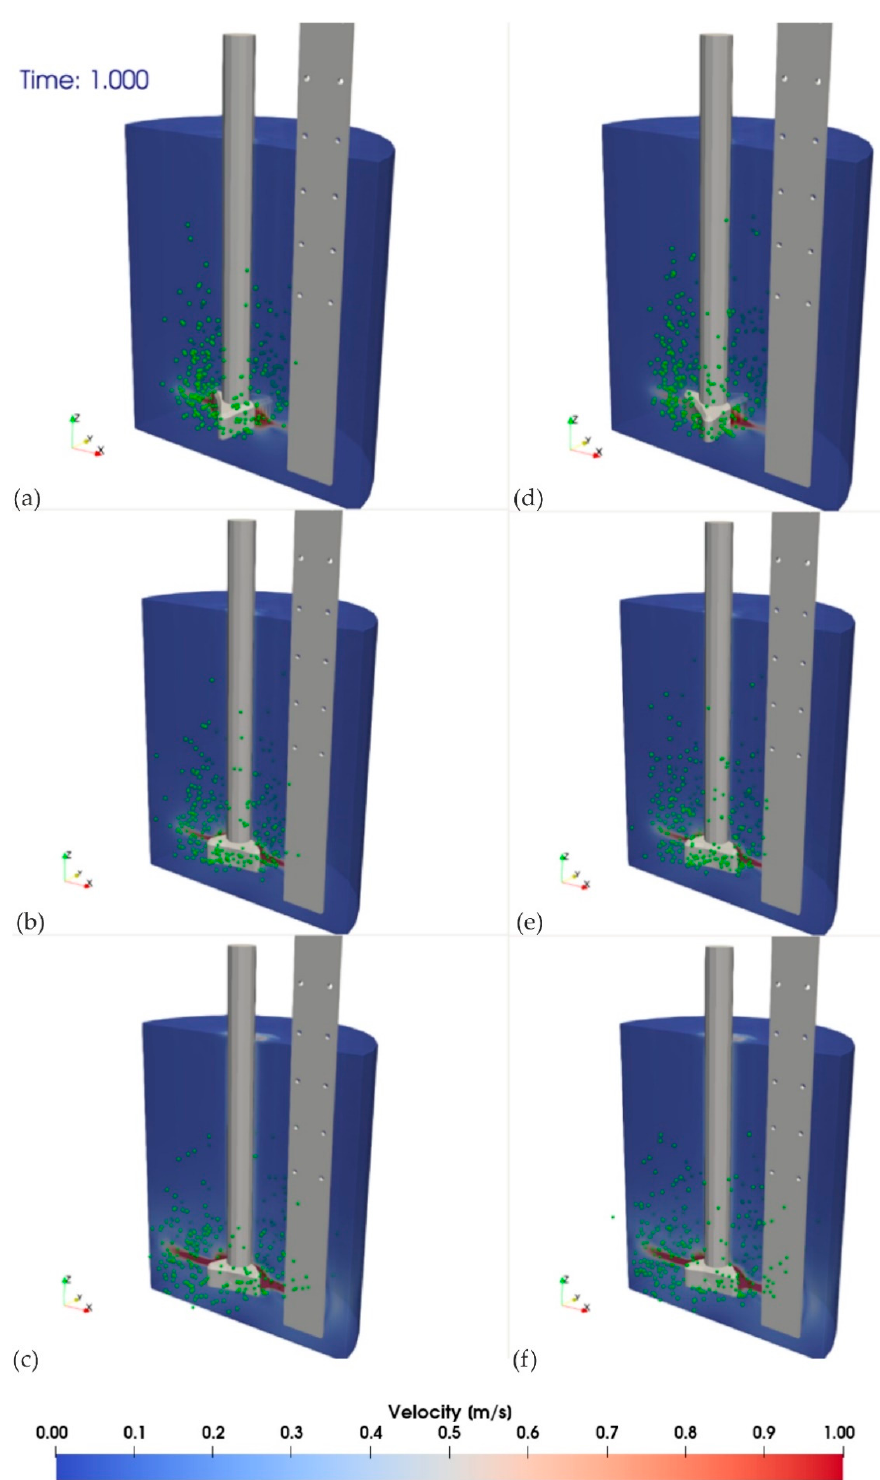
Figure 15. Simulation results of the impeller RT3, for given flows and rotational speeds after a time of 1 s: simulation variants ( a ) A, ( b ) B, ( c ) C, ( d ) D, ( e ) E, and ( f ) F.